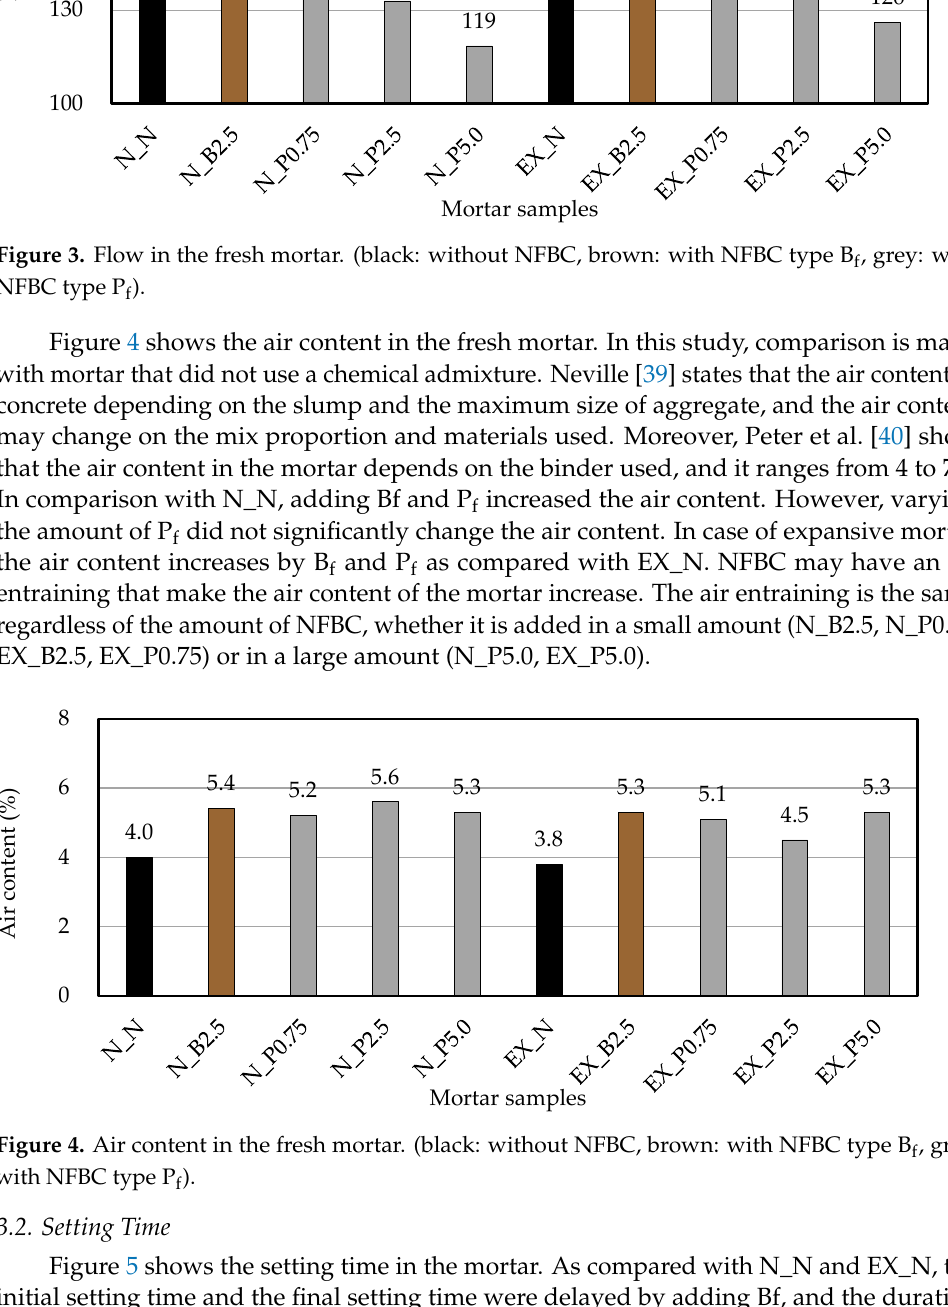
Figure 5. Setting times in ordinary and expansive mortars. (black: without NFBC, brown: with NFBC type B f , grey: with NFBC type P f ) 3.3. Expansion Coefficient under Restraint Condition Figure 6 shows the expansion coefficient under restraint condition. In EX_N, the re- straint expansion coefficient at 7 days was approximately 190 × 10 − 6 . This meets the stand- ard set by the Architectural Institute of Japan for a restraint expansion coefficient of 150 × 10 − 6 or greater at 7 days when using Ex [41]. As compared with EX_N, with B f , the restraint expansion coefficient was almost unchanged, but the expansion start time was delayed.